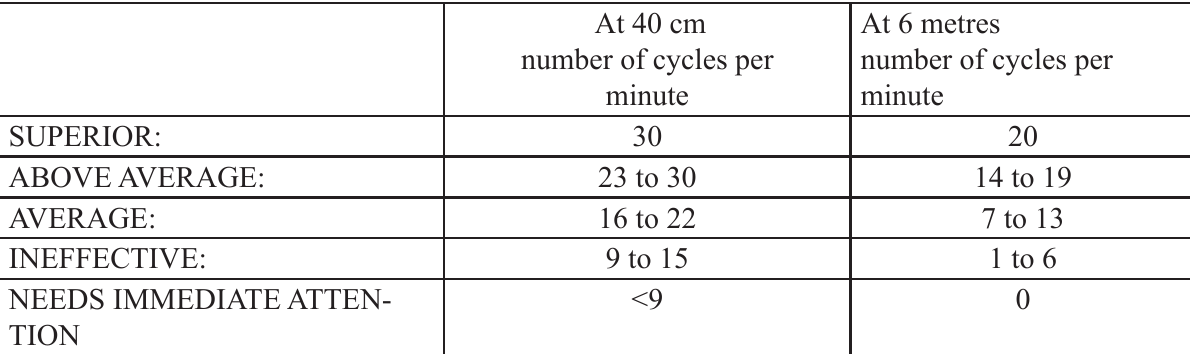
Table 7: The norms obtained for Fusion Flexibility (Binocularity) with the use of 6 prism dioptres base in and 12 prism dioptres base out flippers at 40 cm and at 6 metres